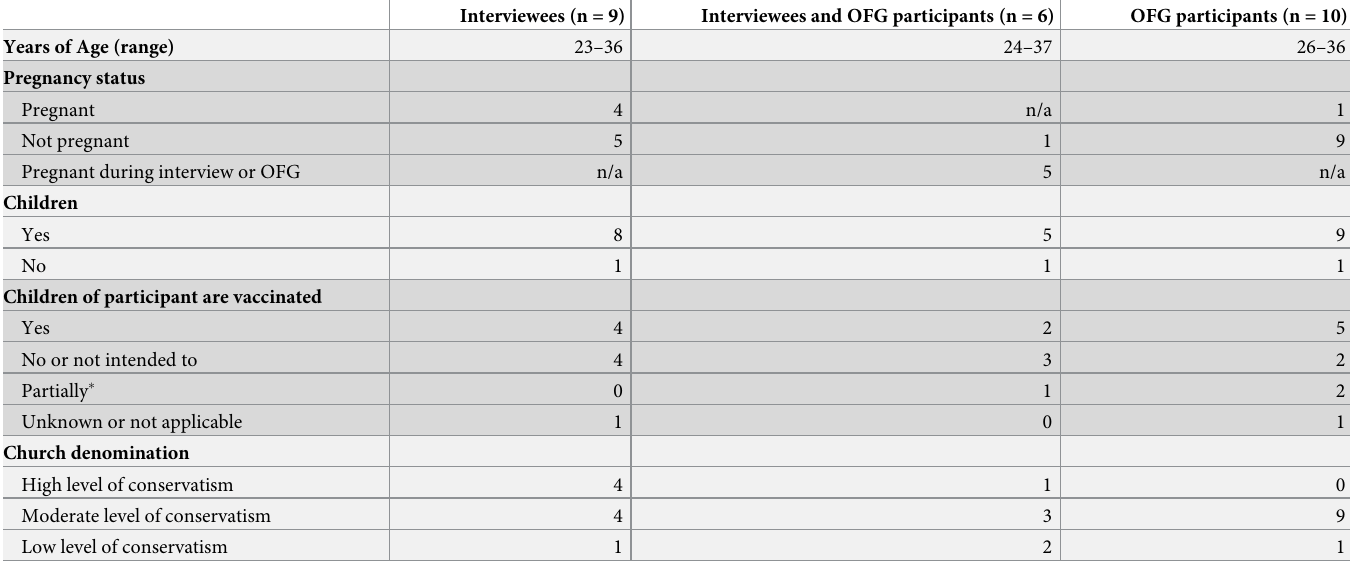
Table 3. Participant characteristics of interviewees, interviewees who participated in an online focus group, and online focus group participants (total N =